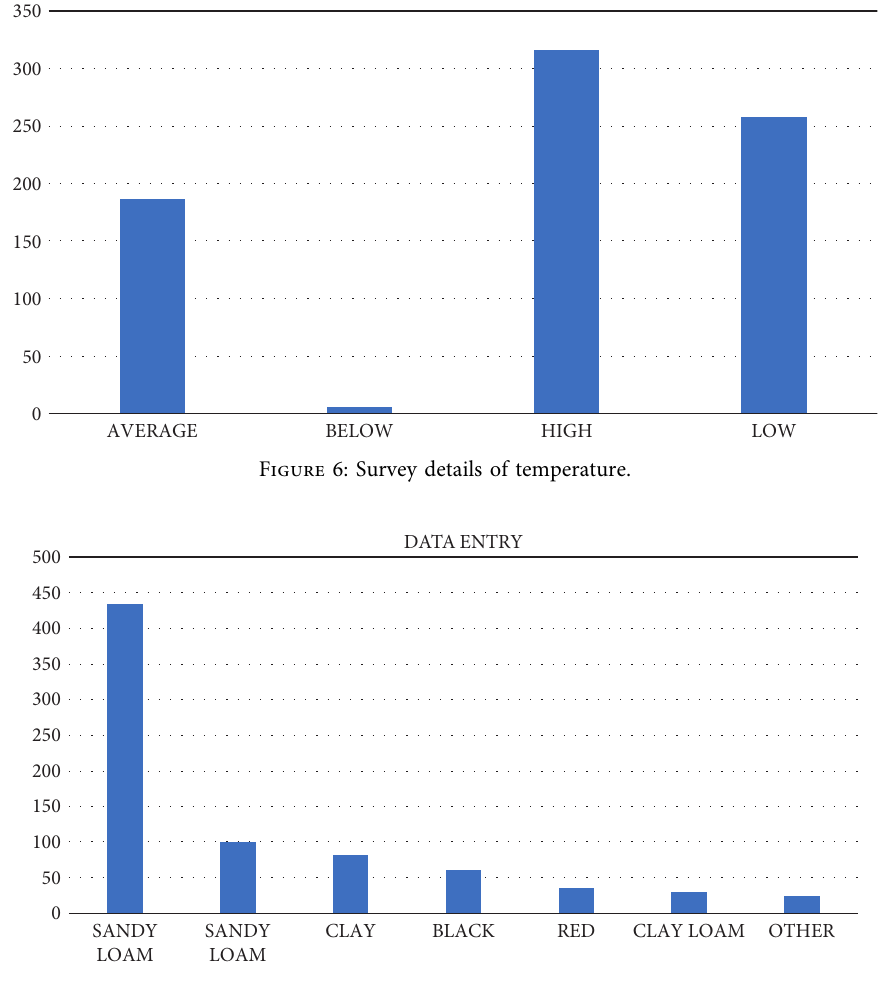
Figure 7: Survey details of type of soil. Table 2: CART result.